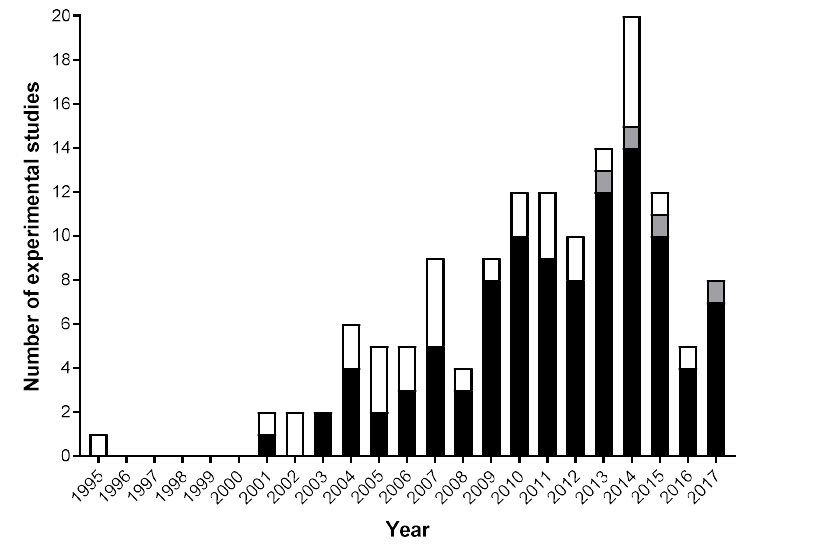
Figure 2. The number of experimental studies of Batrachochytrium dendrobatidis (Bd), B. salamandrivorans (Bsal) and Ranavirus (Rv) by year.